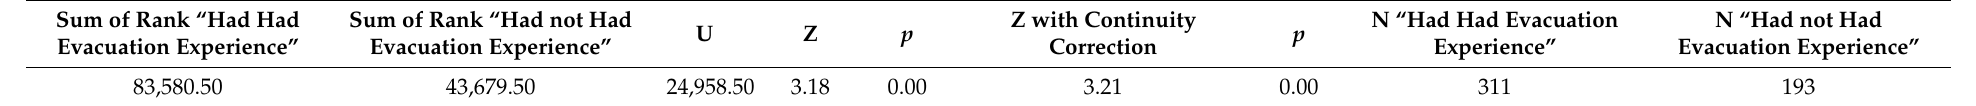
Table 2. Comparison of knowledge between individuals with and without evacuation experience—the Mann–Whitney U test results. Results marked by red are significant with p < 0.05. Sum of Rank “Had Had